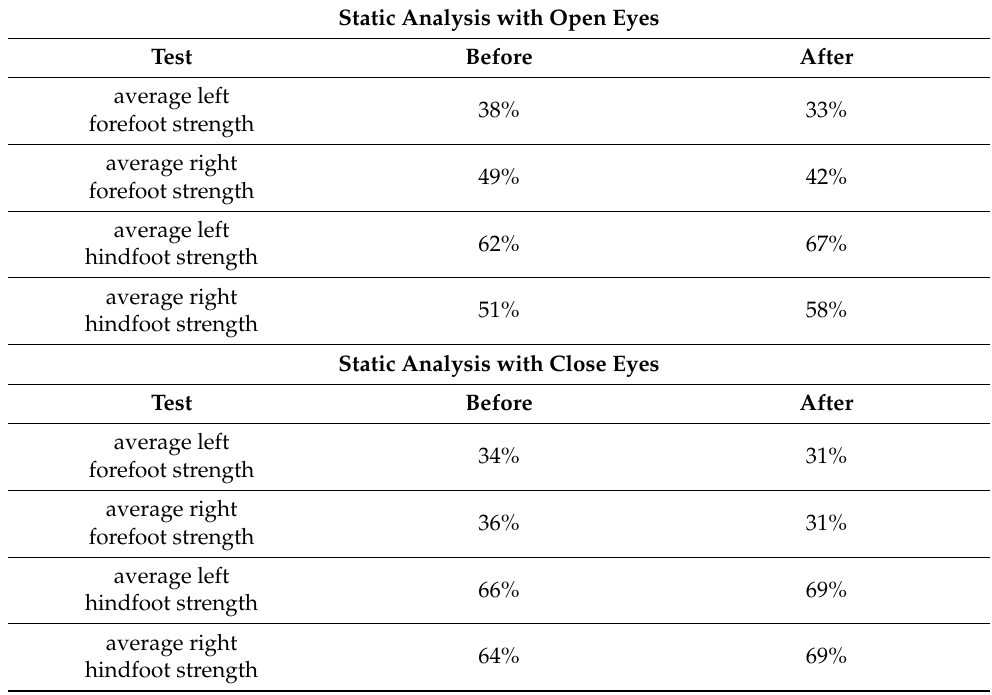
Table 1. Balance static analysis with open and closed eyes before and after the CAREN VR rehabilita- tion program. Static Analysis with Open Eyes Test Before